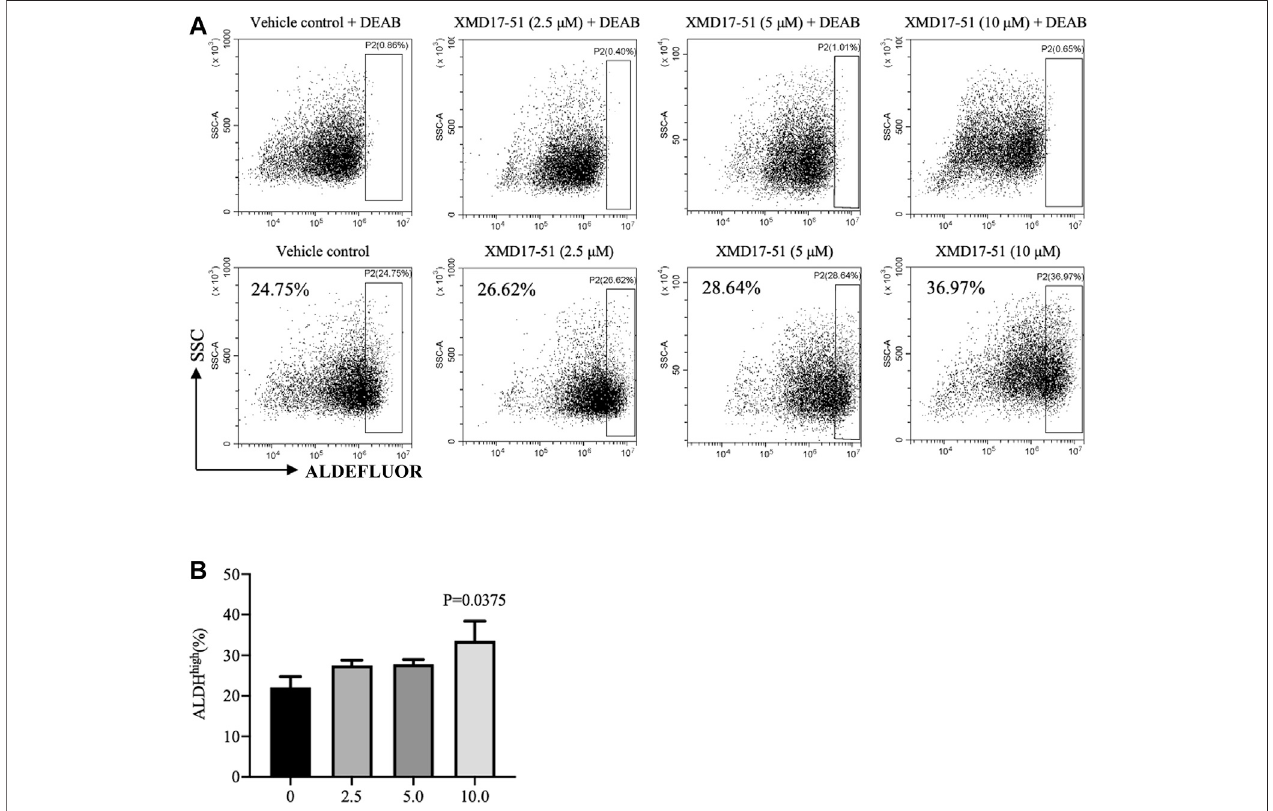
FIGURE5|(A) AsafunctionalreadoutofALDHactivity,A549cellstreatedwithdifferentconcentrationsofXMD-17-51weretestedusingtheALDEFLUORassay.A speci fi c inhibitor of ALDH, diethylaminobenzaldehyde or DEAB, was used as a negative control. (B) Higher XMD-17-51 concentration correlated with an increase in the number of ALDH high cells. Data are presented as fold change relative to the levels in vehicle control cells and are presented as mean ± SD.